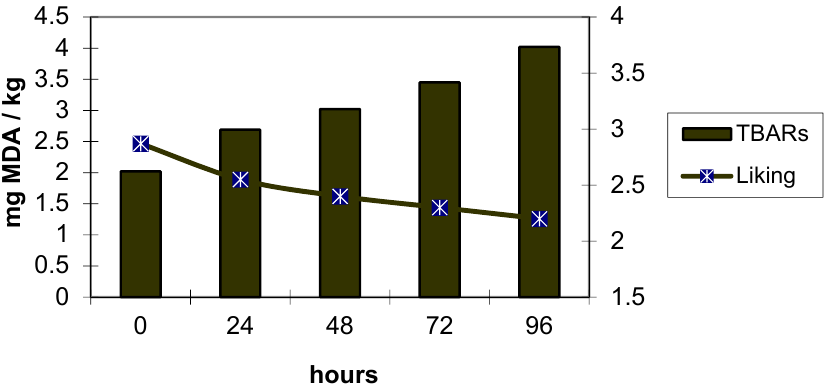
Figure 1. Relationship between evolution of TBARS and liking in Kabir meat (modified by [6]). MDA: Malondialdehyde; TBARS: Thiobarbituric acid reactive substances.